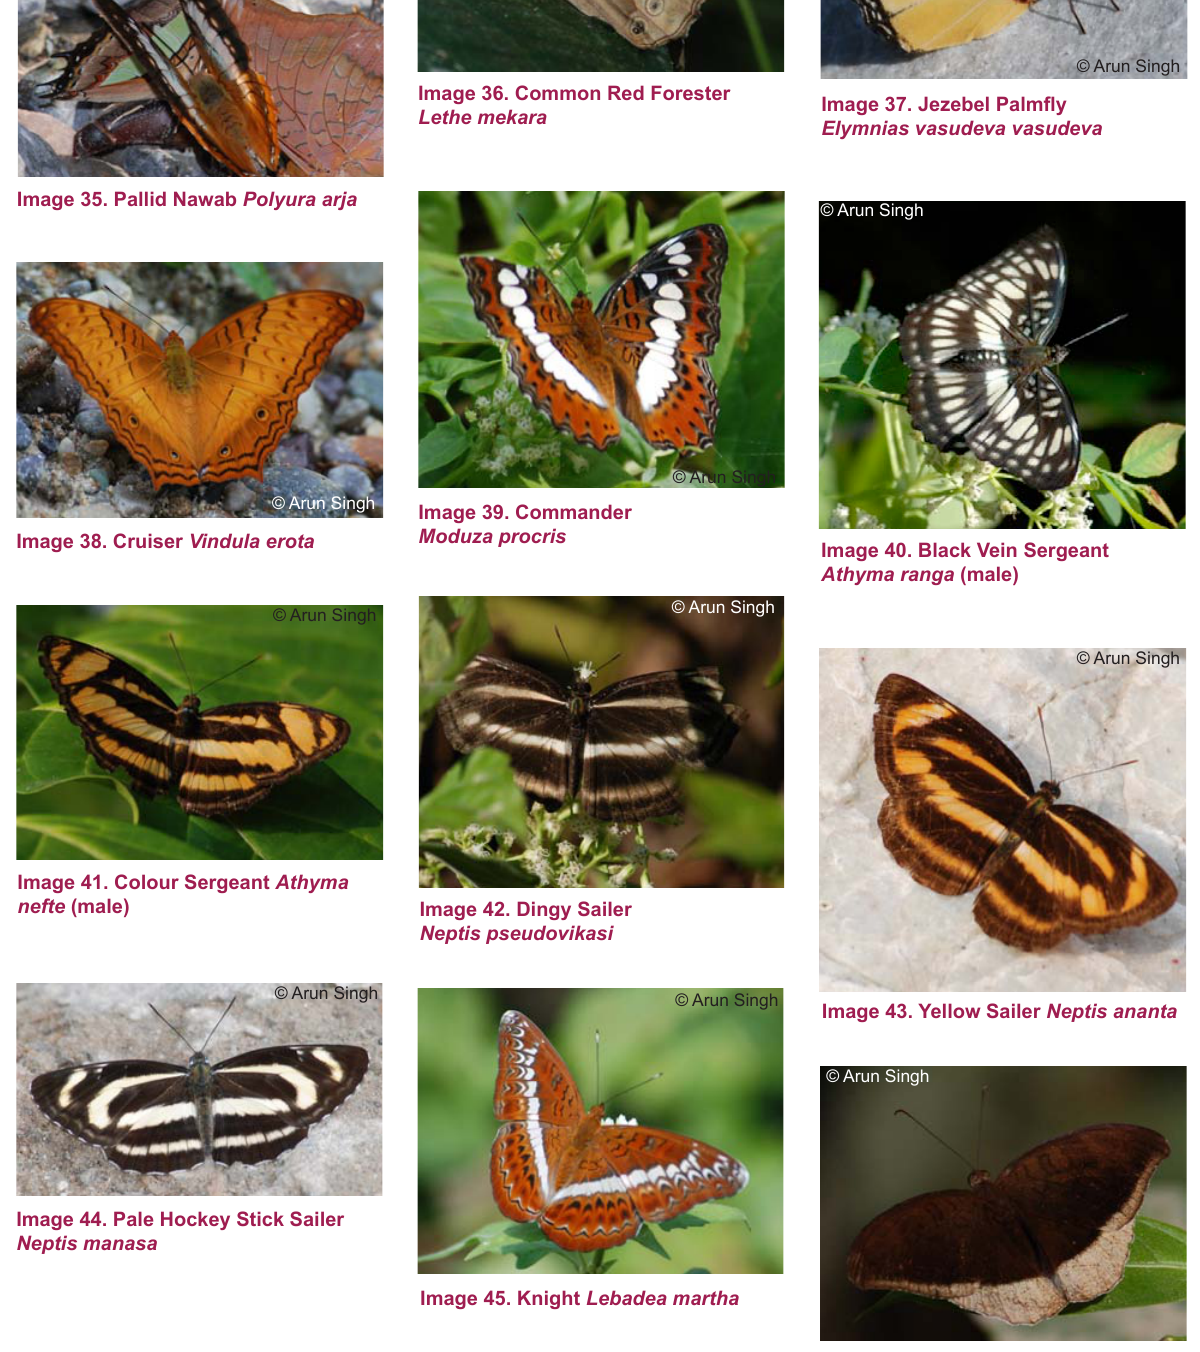
Image 46. Grey Count Tanaecia lepidea